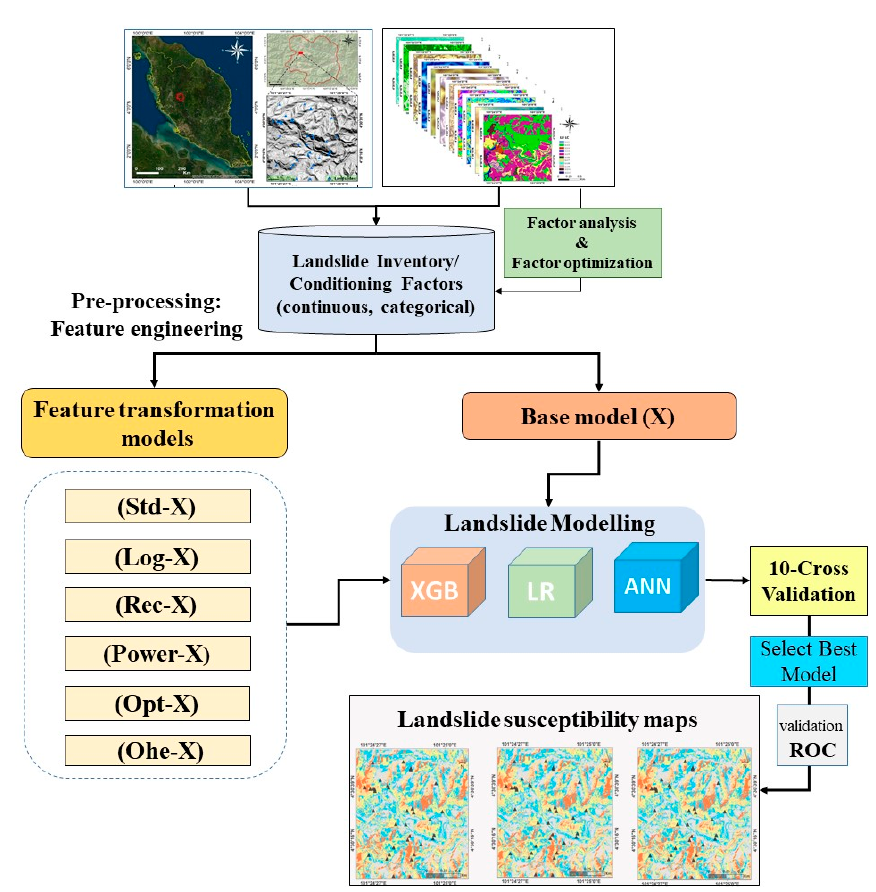
Figure 3. Overall flowchart of the current study.